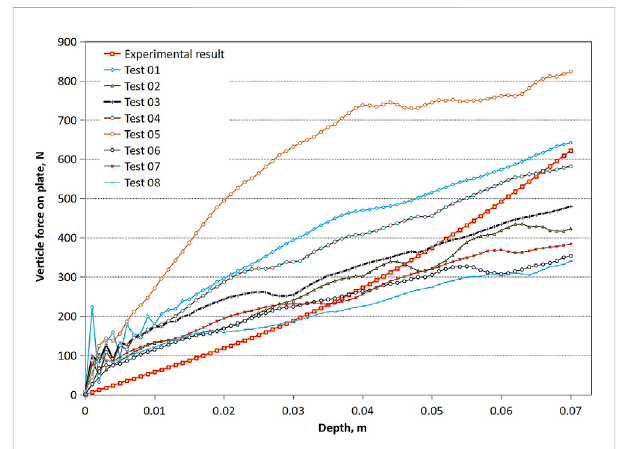
FIGURE 8 A series of trial runs for determining the parameters of the in- house program.